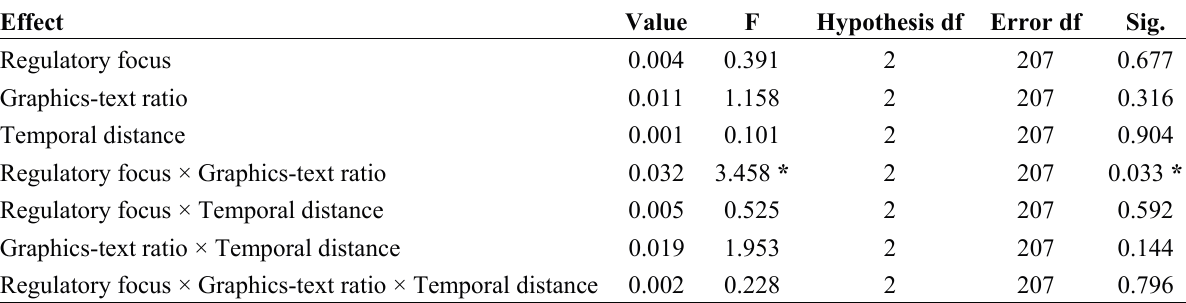
Table 3. Multivariate tests.